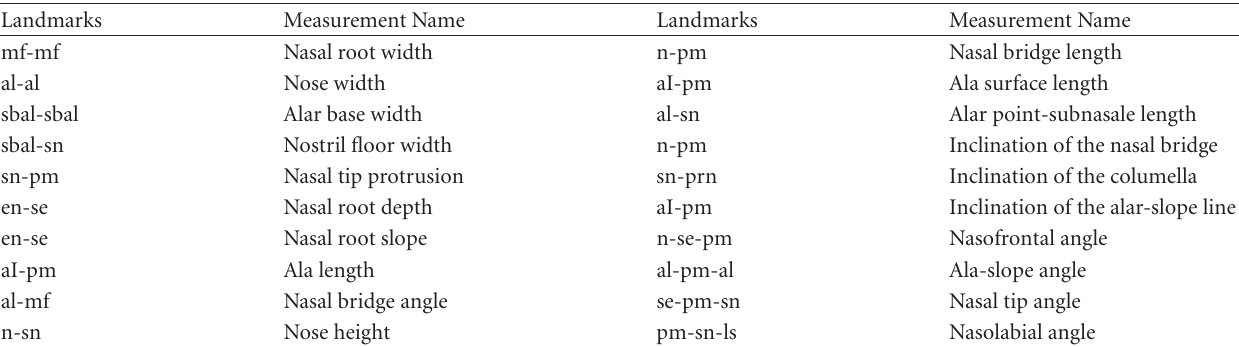
Figure 6: Head geometry with anthropometric landmarks (green dots). The landmark names are taken from [5]. Table 1: Anthropometric measurements of the